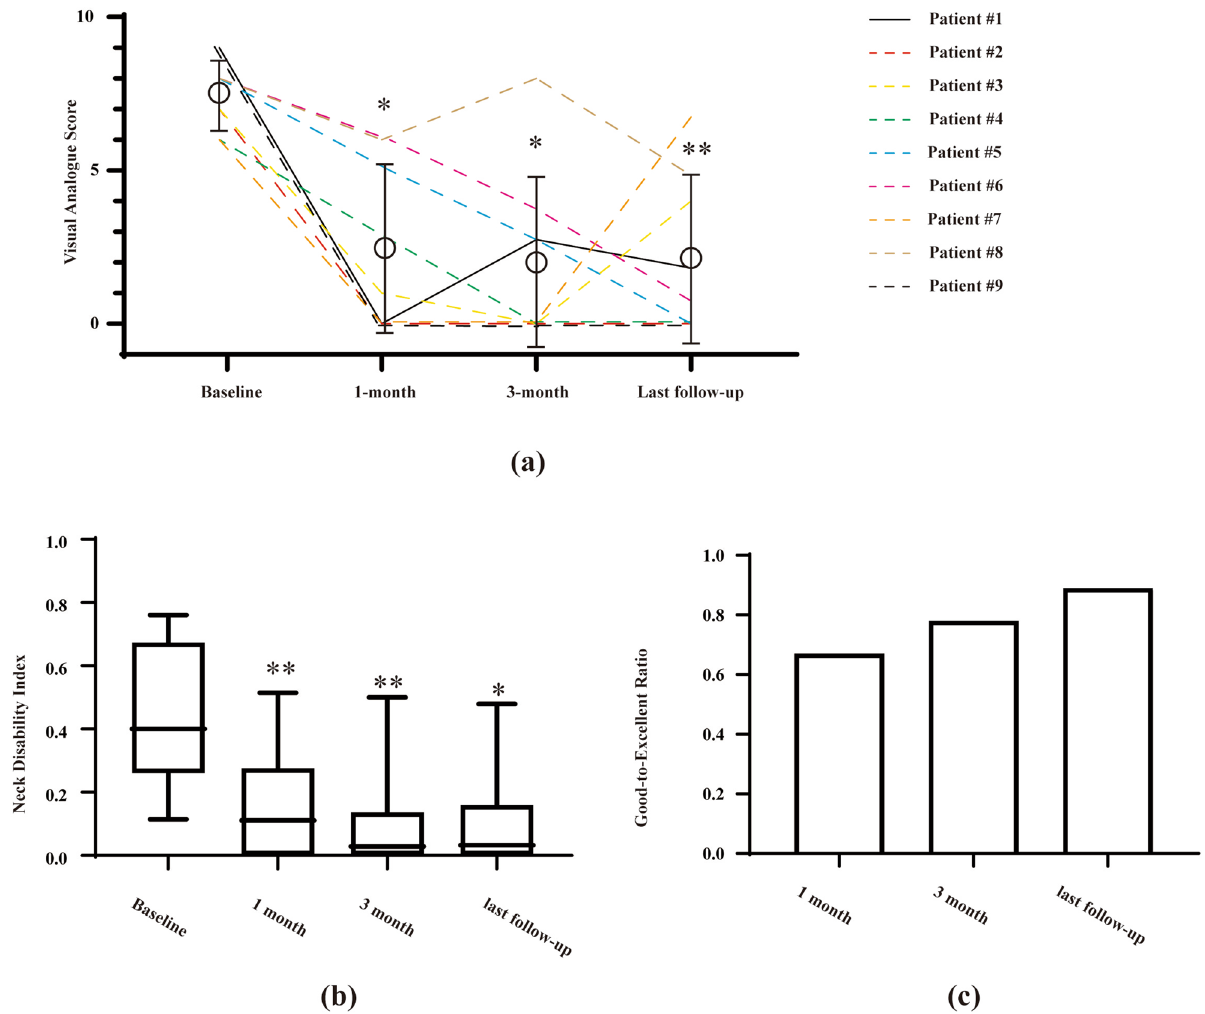
Figure 6. Comparisons of clinical outcomes pre- and post- PLD therapy. ( a ) Pain severity assessed by the VAS at 1-, 3-month, and last follow-up. Each line indicated one individual patient respectively across different follow-up points. Pain scores were compared between baseline and each follow-up time point, with Friedman’s non-parametric test and one-way ANOVA. *p < 0.05, **p < 0.01. ( b ) Significant functional improvement was achieved by the ultrasound-guided PLD. The NDI data is plotted as median with its range. Friedman’s non- parametric test and one-way ANOVA. *p < 0.05, **p < 0.01. ( c ) The modified Macnab Criteria collected at each time